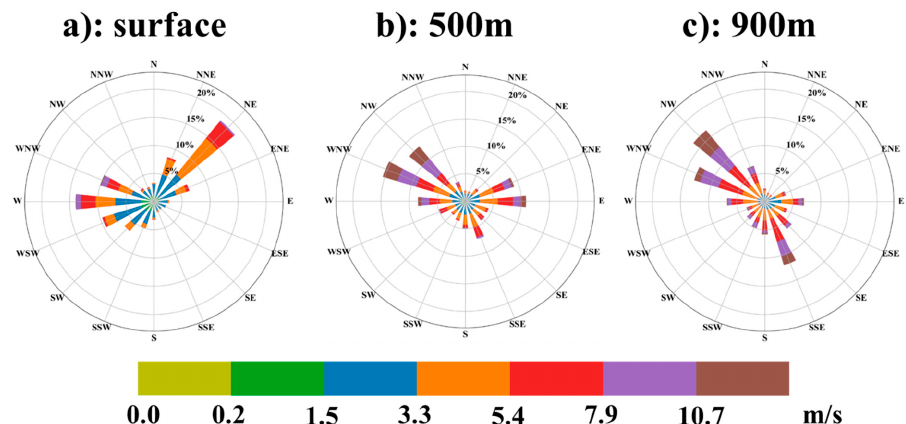
Remote Sens. 2021 , 13 , x FOR PEER REVIEW Figure 4. Wind rose plots based on frequency of wind all day (day and night) at ( a ) surface, ( b ) 500 m and ( c ) 900 m altitude Notes: radial scale in the wind rose plots represents count frequency of wind direction; color represents wind speed.